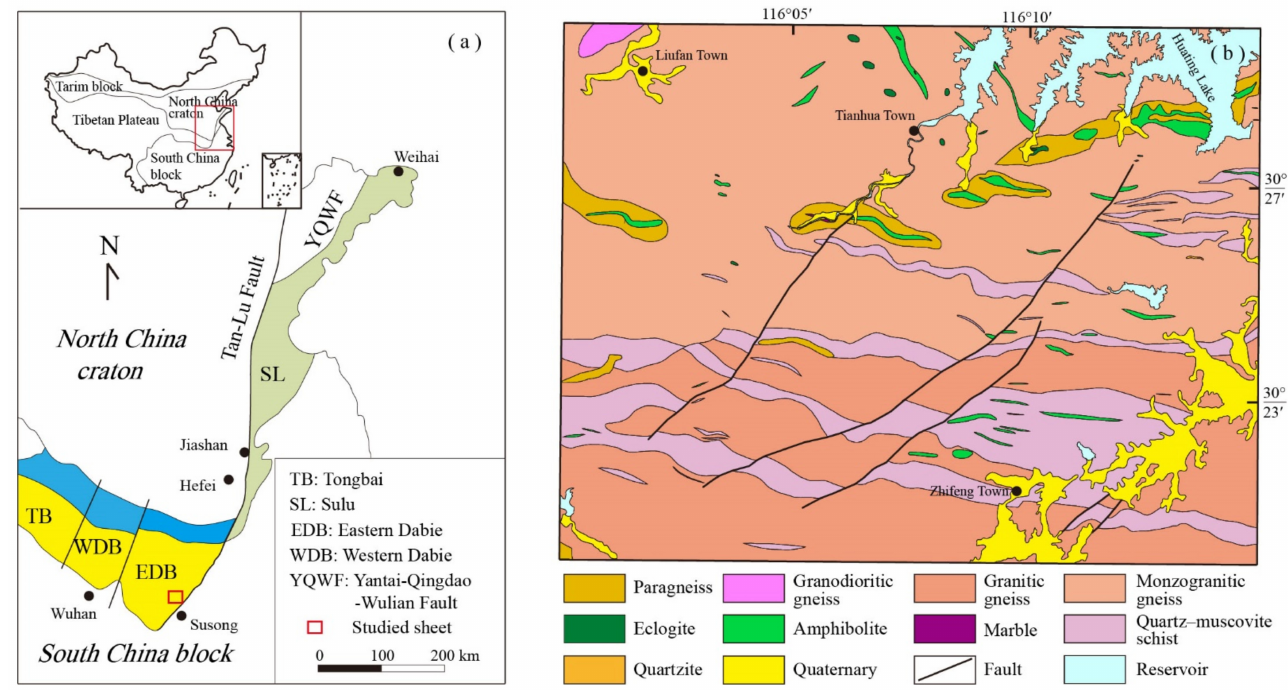
Figure 6. ( a ) Schematic tectonic map for the Dabie-Sulu orogenic belt in central and eastern China, showing the location of the 1:50000 Fengxiangyi sheet. The inset shows the major tectonic divisions of China (modified after Qiu et al., 2021 [52]); ( b ) simplified geological map of the Fengxiangyi sheet, showing the distribution of